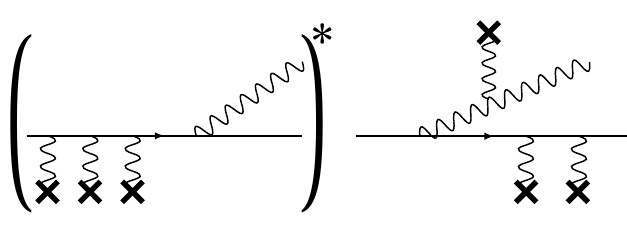
Figure 1 . Example of interference between diagrams where the emission occurs before and after multiple scatterings with thermal plasma. Here the cross denotes the thermal plasma. Such interference leads to the LPM